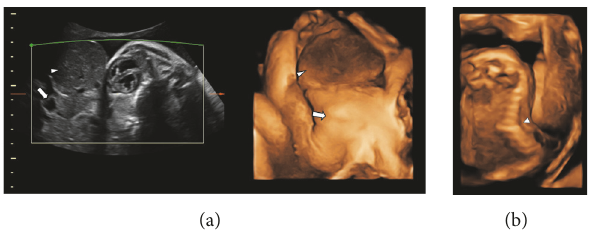
Figure 1: (a) 2D and 3D ultrasound image showing abdominal wall defect with liver (short arrow) and small bowel (long arrow) herniation at 33 weeks of gestation. (b) 3D ultrasound image showing kyphosis of the thoracolumbar spines at 22 weeks of gestation (arrow).